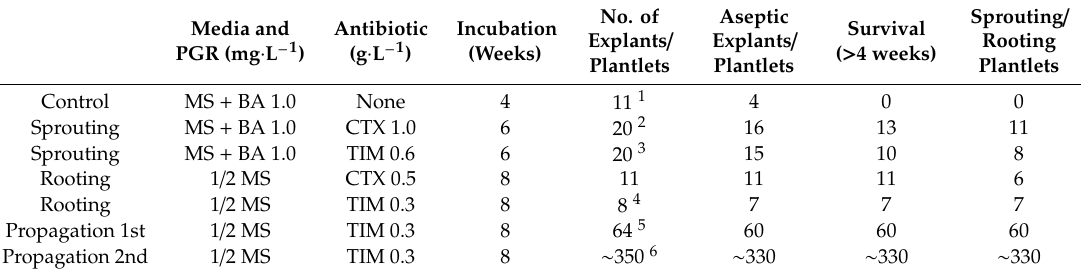
Table 1. The e ff ect of antibiotics on the in vitro culture of M.